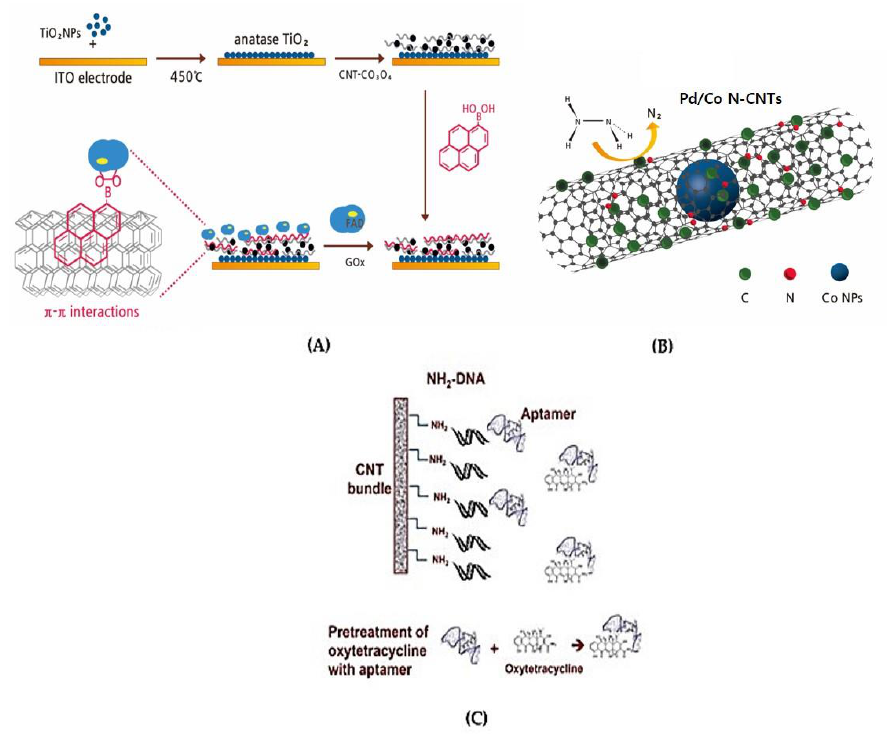
Figure 10. CNT-based biosensor for various biomaterials food assessment. ( A ) A glucose biosensor based on supercapacitor Co 3 O 4 -CNT hybrid on TiO 2 [113]; ( B ) A hydrazine sensor based on Pd/Co N-CNTs [114]; ( C ) Apt/SWCNT-based electrochemical biosensor for detecting OTC [69]. Zhang et al. [114] developed a CNT-based electrochemical biosensor using Pd NPs blended with Co NPs inside of nitrogen-doped carbon nanotubes (Pd/Co-NCNTs) on GCE for the hydrazine detection by CV and EIS (Figure 10B). The Co-NCNTs combined with Pd NPs using pyrolysis led to a high catalytic response and a low overpotential for hydrazine oxidation. The sensor capacity of the Pd/Co-NCNTs/GCE biosensor was a lin- ear DR of 0.05 –406.45 μM with an LOD of 7.0 × 10 −3 μM, demonstrating long -term stability and good sensitivity with a fast response time of at least 2 s. As mentioned before, a simple and highly sensitive Apt-based SWCNT biosensor containing probe-DNA immobilized on functionalized SWCNTs was designed by Yildirim-Tirgi et al. [69] for the detection of OTC and widely employed to resist bacterial infections in livestock and affect their growth rate (Figure 10C). The sensor was fabricated by applying a high-rate nanoscale offset printing process using a directed assembly of SWCNTs with non-covalent functionaliza- tion of probe DNA-SWCNTs on two electrodes for the continuous sensor response for OTC antibiotics detection. The developed Apt biosensor had a DR of 10 – 75 mg/L (20 – 325 nM) with a LOD of 1.125 mg/L (2.5 nM). Thus, the biosensor was straightforward and fast (less than 10 min for pre-incubation, measurement, and regeneration) with an inherently small size for in vivo applications. 4. Conclusions Biosensor technology can be used in the food industry for tasks such as component analysis, rapid detection of natural toxins and antinutrients, detection of enzyme inacti- vation and microbial contamination during food processing and storage, measurement of harmful substances produced by the interaction of food ingredients, and determination of the freshness of fish and antioxidant activity. The development of CNTs for detecting bi-